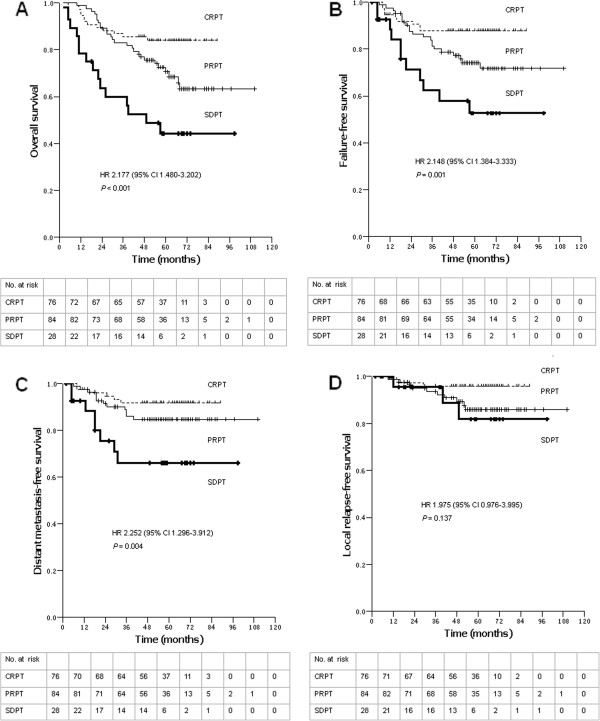
Survival rates of 188 nasopharyngeal carcinoma patients. (A) Overall survival, (B) failure-free survival, (C) distant metastasis-free survival, and (D) local relapse–free survival rates of patients with complete response of primary tumor (CRPT), partial response of primary tumor (PRPT), and stable disease of primary tumor (SDPT) at the end of radiotherapy. Hazard ratios (HR) were calculated with the unadjusted Cox proportional hazards model; P-values were calculated with the unadjusted log-rank test. 95% CI, 95% confidence interval.